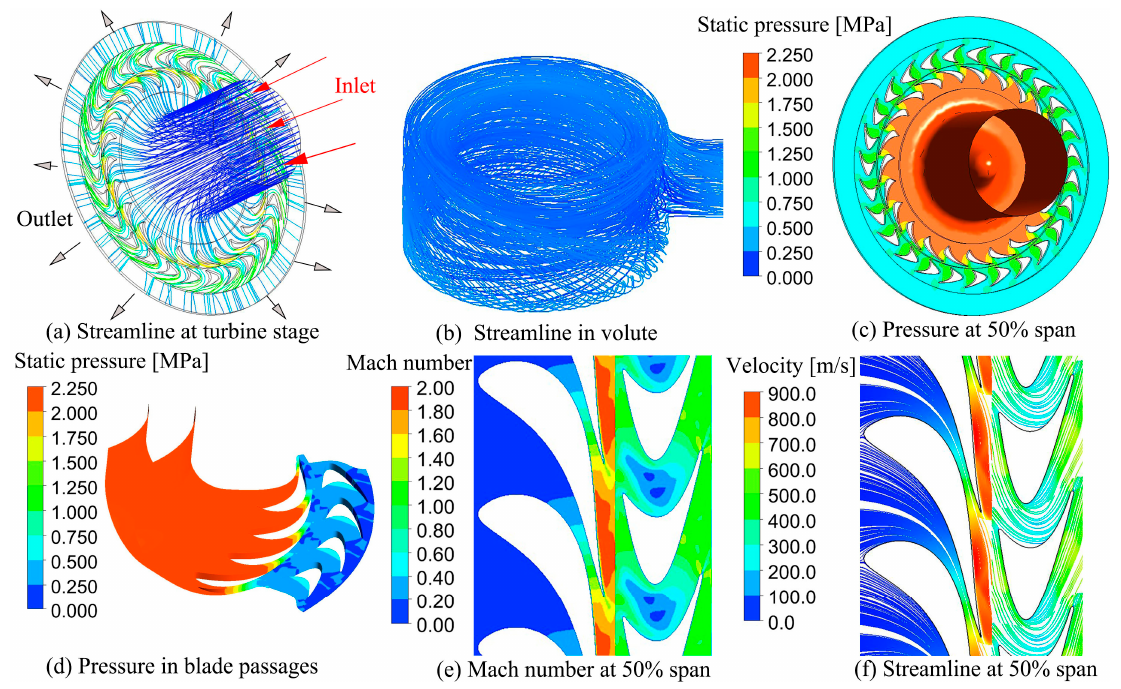
Figure 7. Predicted design flow behavior of original turbine.